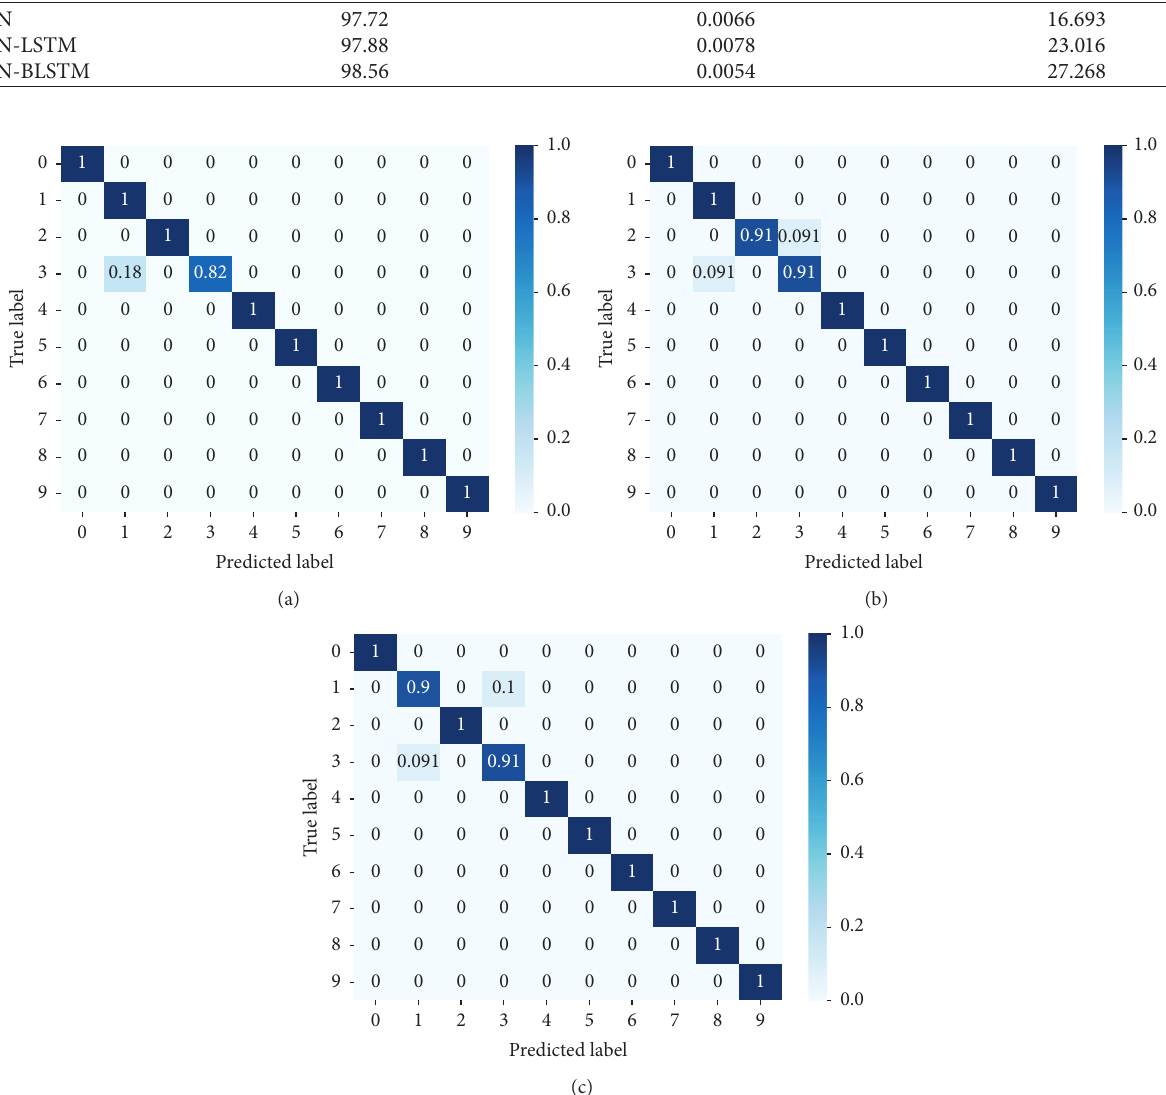
Figure 6: The mode of the three models in 10 classifications was 98.31%. (a) CNN-BLSTM model. (b) CNN-LSTM model. (c) CNN